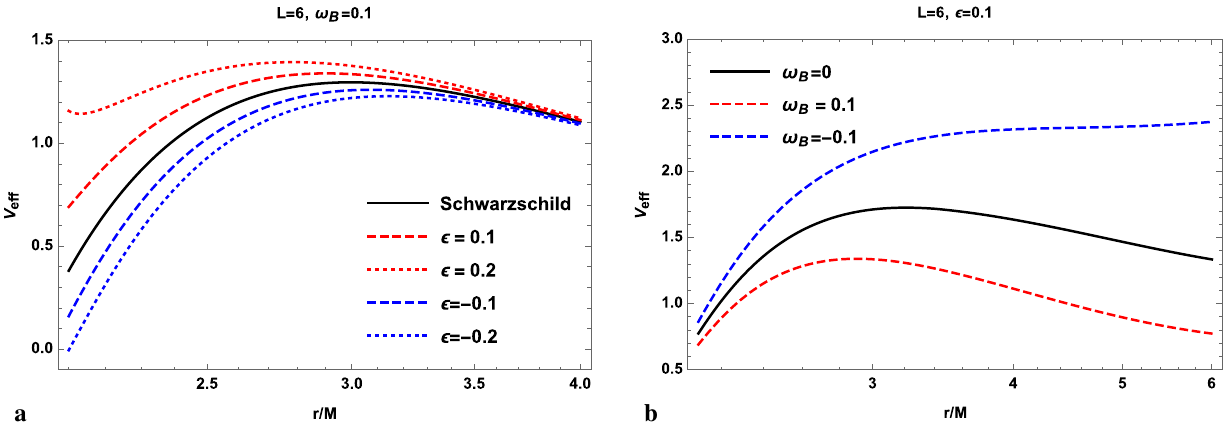
a b Fig. 1 Effective potential as a function of radial coordinate r for the case M = 1. The left panel corresponds for the variation of the deformation parameter. The right panel is for the variation of the magnetic